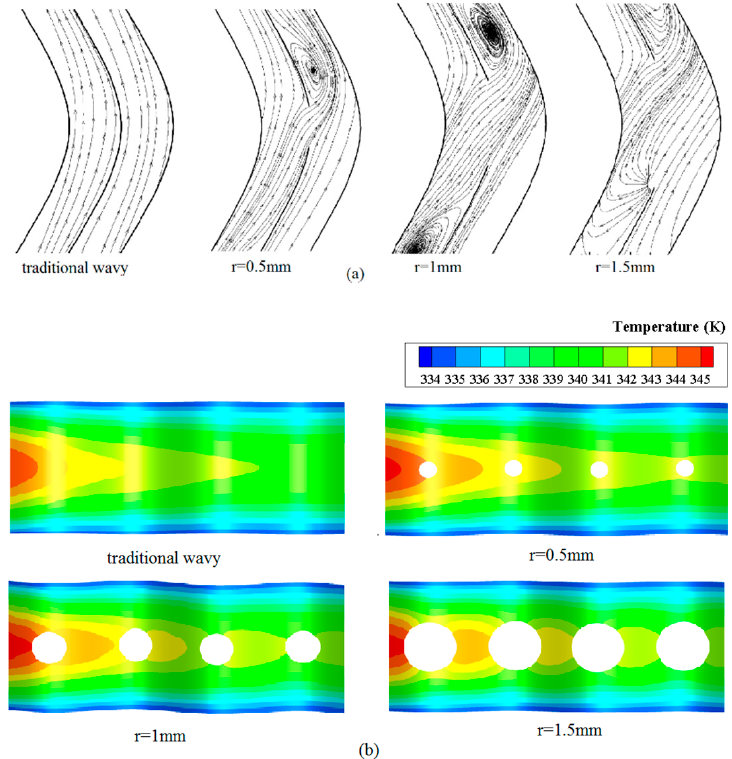
Figure 6. ( a ) Change in the streamline and ( b ) fin surface temperature distributions of the traditional wavy fin and perforated wavy fin when the radii are 0.5 mm, 1 mm and 1.5 mm.